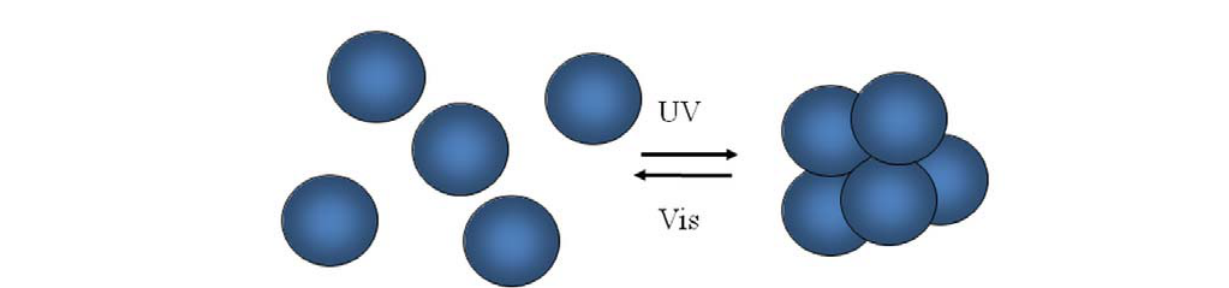
Figure 38. Photo-assembly of liposomes induced by metal chelates from gemini peptide lipids 7